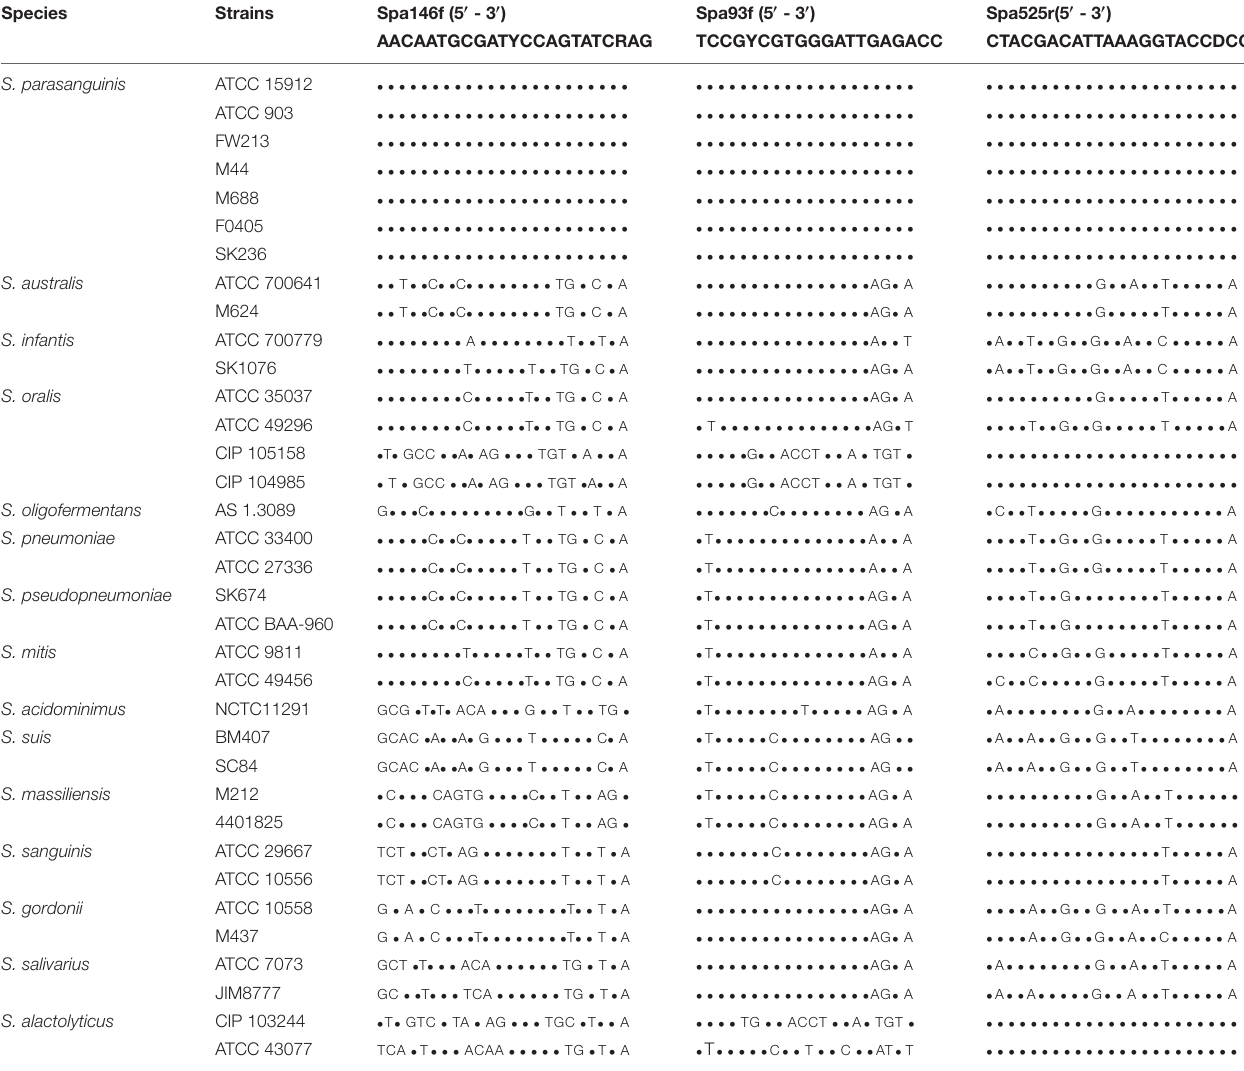
TABLE 2 | The sequence alignment of the S. parasanguinis -specific primers with the groEL gene of strains of Streptococcus spp. Species Strains Spa146f (5 (cid:48) - 3 (cid:48)